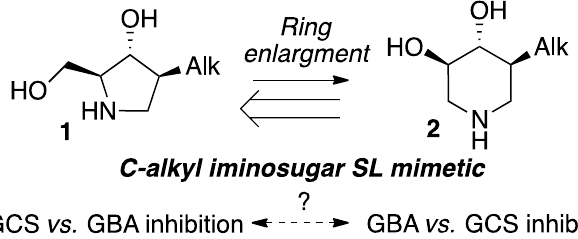
Scheme 2. C -alkyl iminosugar sphingosine mimetics and opportunities thereof.